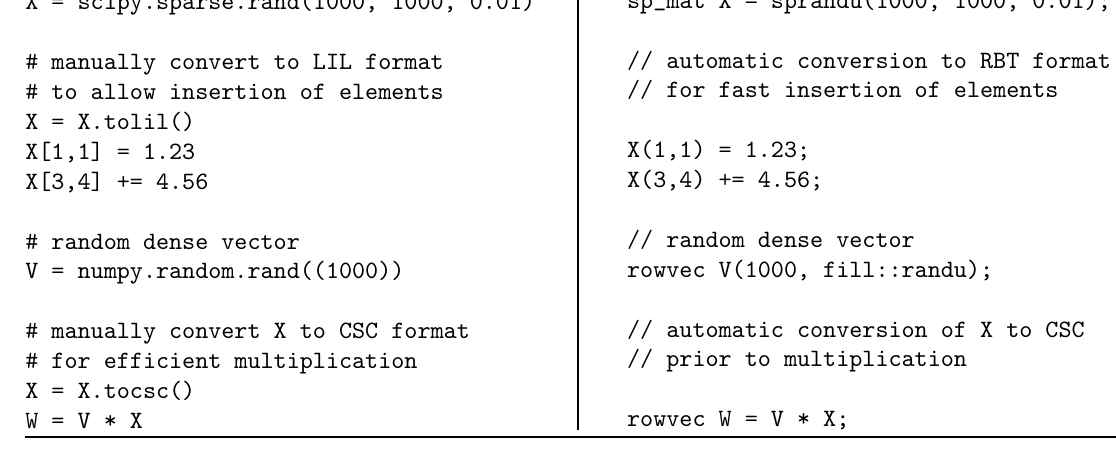
Figure 3. Left panel: a Python program using the SciPy toolkit, requiring explicit conversions between sparse format types to achieve efficient execution; if an unsuitable sparse format is used for a given operation, SciPy will emit TypeError or SparseEfficiencyWarning . Right panel: A corresponding C++ program using the sparse matrix class, with the format conversions automatically done by the